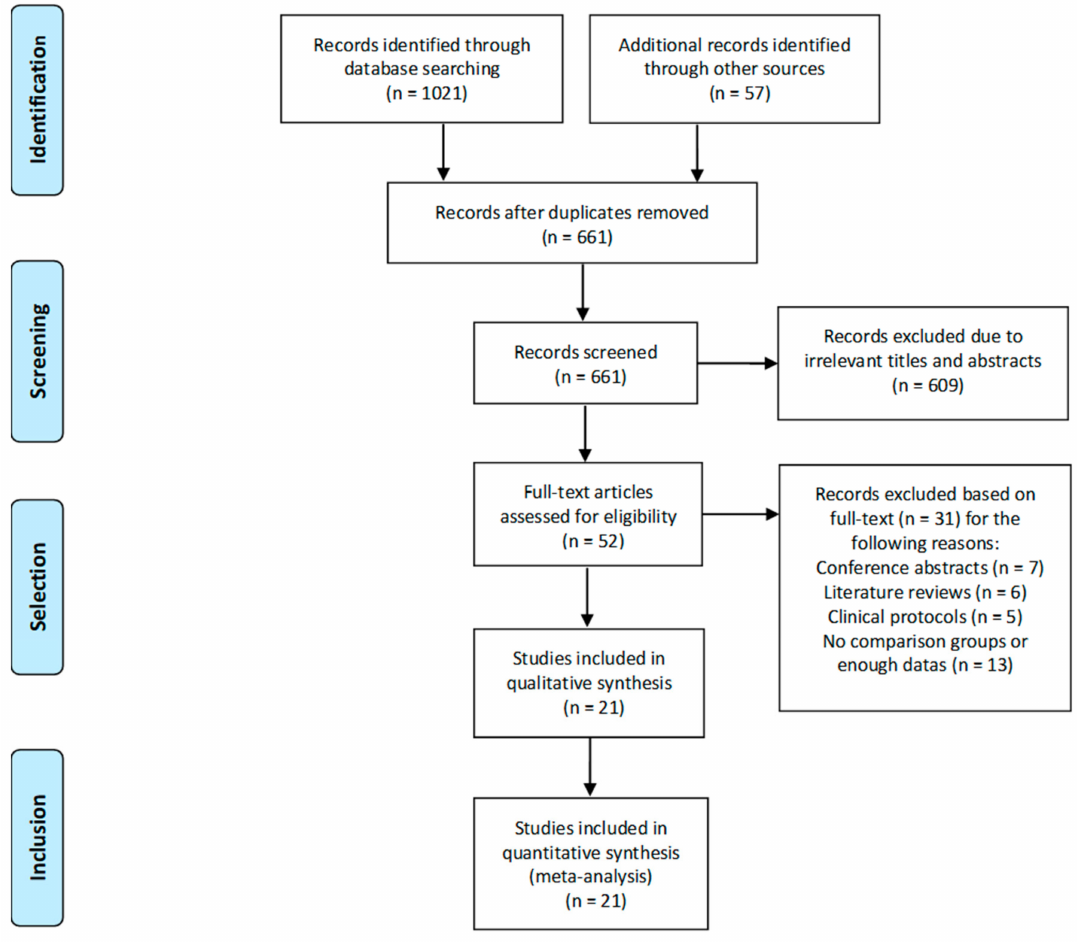
Figure 1. Selection process of the